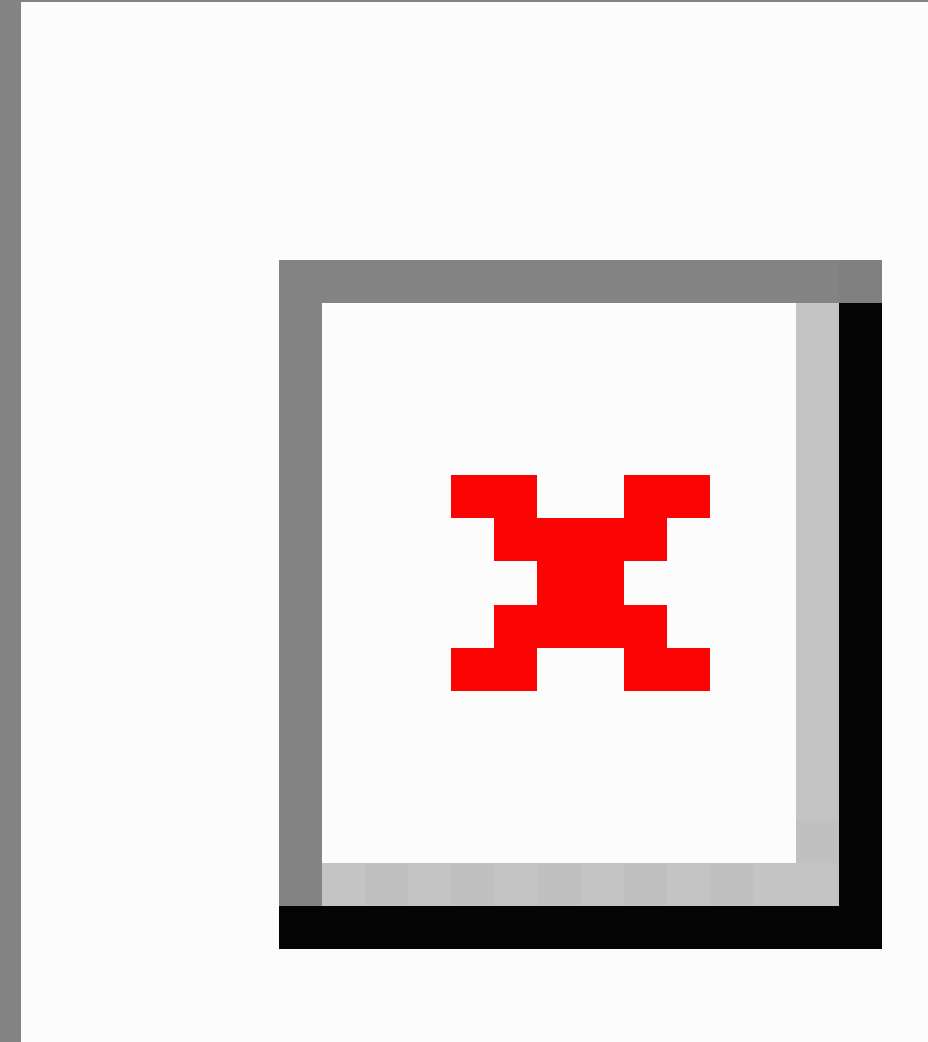
Figure 1. Flow diagram of study